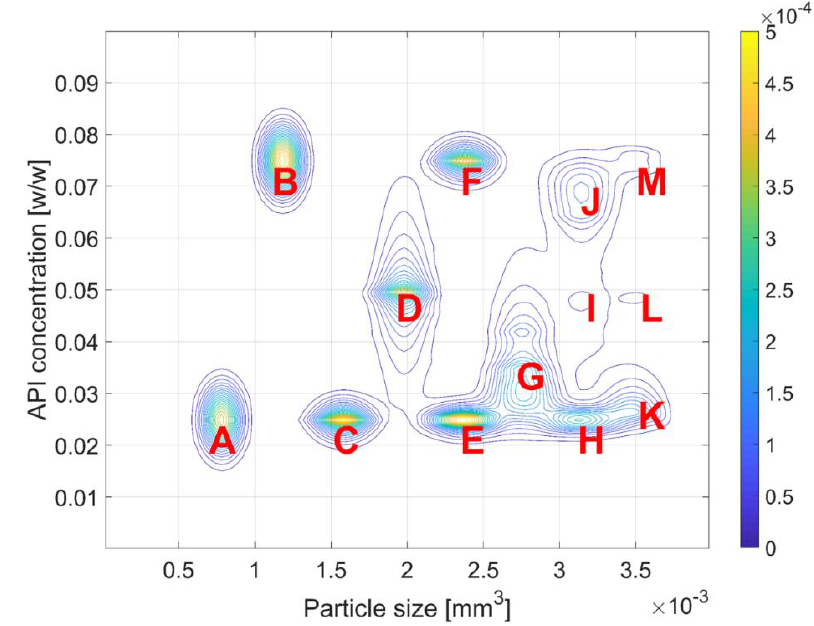
Figure 7. Agglomeration diagram. Table 2. Material transitions during agglomeration.